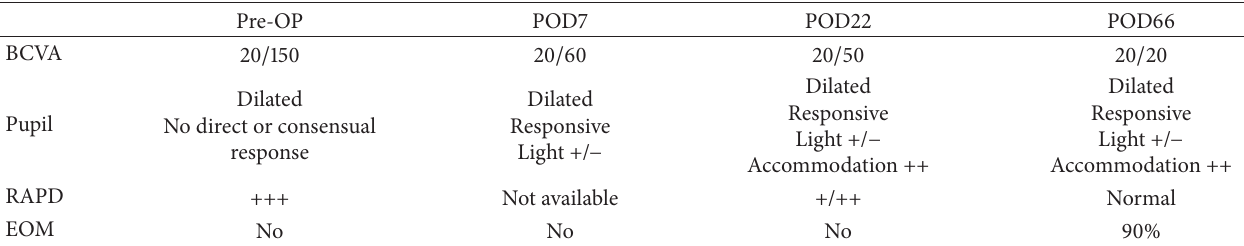
Figure 1: Horizontal head CT showing a metallic foreign body in the right apex. Table 1: Right eye exam during follow-up.